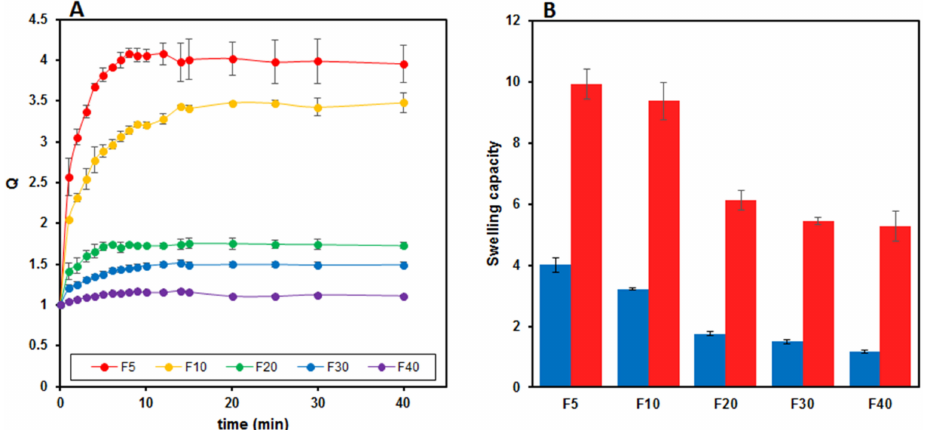
Figure 5. Swelling capacity of nanocomposite films measured in PB (pH = 7.4) at 37.0 ± 0.1 ◦ C. ( A ) Dynamic swelling over time. ( B ) Comparison between the swelling degree (blue bars) and water uptake capacity (red bars) of films with different AgNPs content. Results are reported as the mean ± the standard deviation ( n =